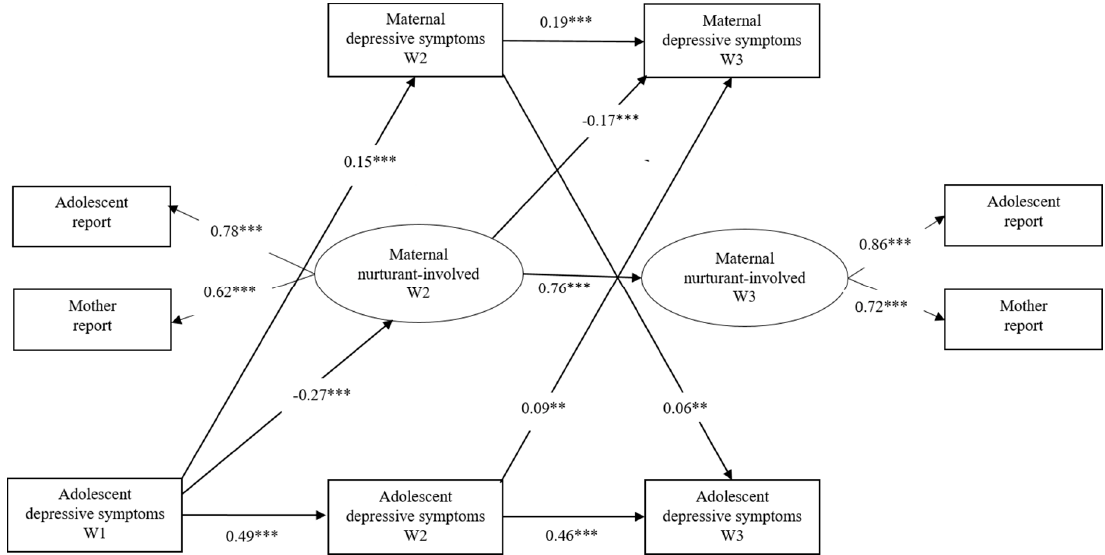
Figure 3. Transactional effects between adolescents’ depressive symptoms, maternal nurturant–involved parenting and maternal depressive symptoms. Maternal nurturant–involved = maternal nurturant–involved parenting. ** p < 0.01, *** p < 0.001.